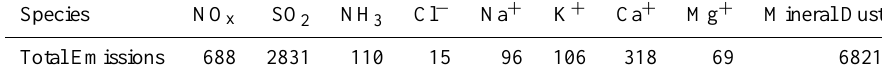
Table 2. Domain wide emissions (tons day − 1 ) of the inorganic aerosol precursors and components.